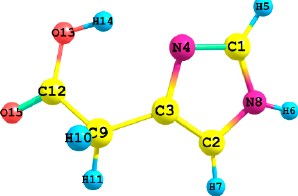
Figure 1. The atom numbering of imidazole-4-acetic acid. Table 1. The bond lengths (Å) of the optimized geometries of H-bonded imidazole-4-acetic acid (I) and imidazole-5-acetic acid (II) using B3LYP, CAM-B3LYP and ω B97XD functionals with 6-311++G** (three top lines) and aug-cc-pvdz (three bottom lines) basis sets. The crystal structure of imidazole-4-acetic acid hydrochloride is given for comparison purposes.